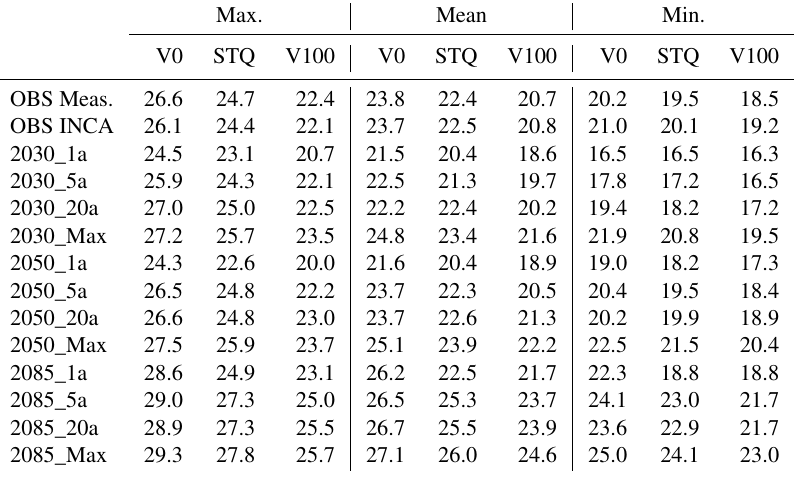
Table 3. Daily minimum, mean and maximum 5-day mean water temperatures of the 5-day episodes averaged over the Pinka during the 1a, 5a, 20a and Max episodes for the climate periods centred on 2030, 2050 and 2085 and mean low flow discharge at DFS 39km. For 2013 (OBS), the measured values of the reference station 2m above the river (Meas.) and interpolated measurement data from the INCA data set used as input are compared.